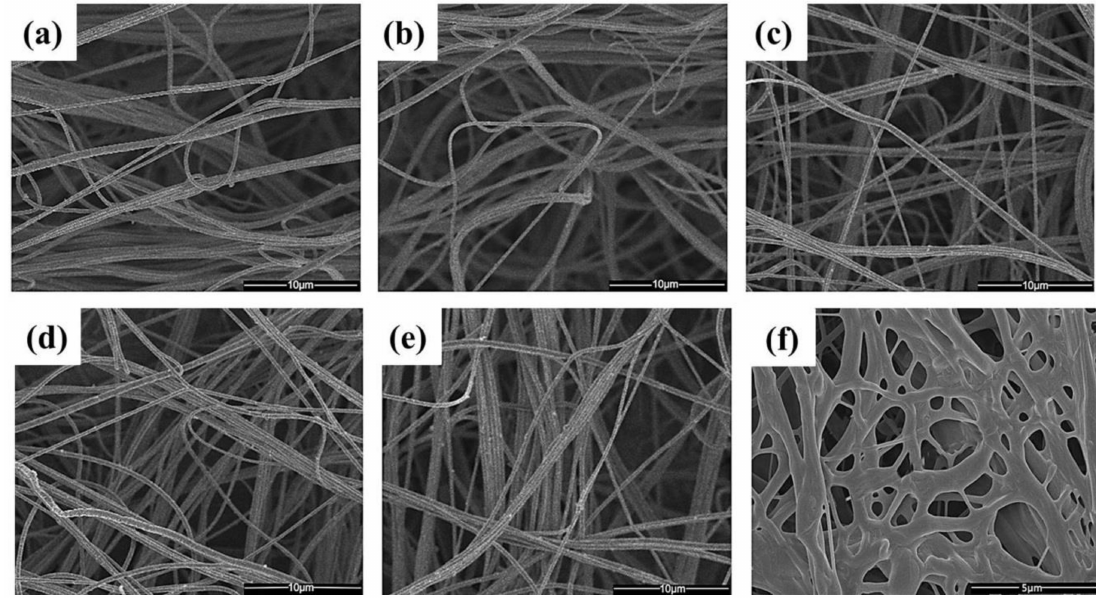
Figure 18. SEM images of solution blown chitosan/PVA nanofibers with different ethylene glycol diglycidyl ether (EGDE) content: ( a ) 7%; ( b ) 5%; ( c ) 4%; ( d ) 3%; ( e ) 2%; and ( f ) the swollen chitosan/PVA/EGDE-7% [253]. Reproduced with permission from ref. [253]. Copyright Elsevier,